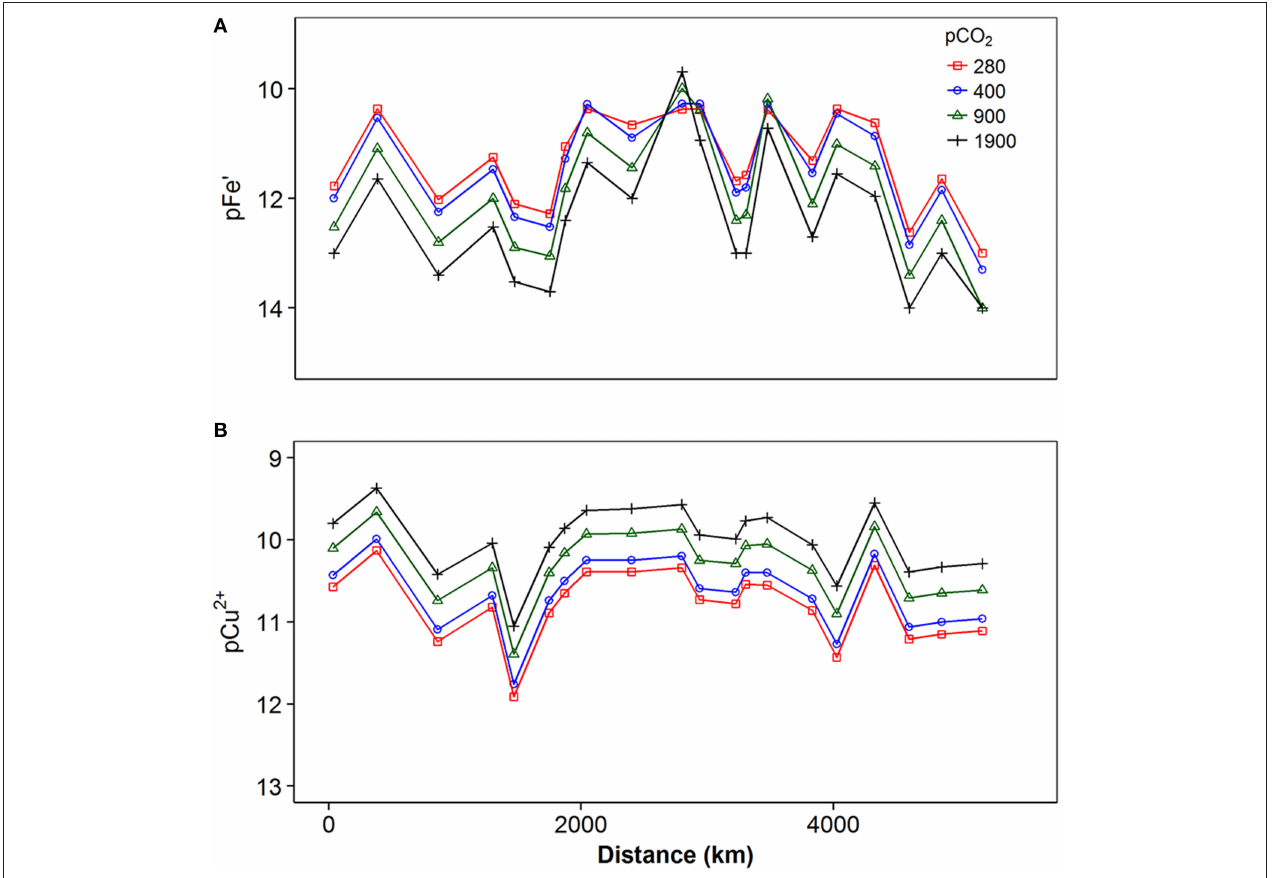
FIGURE 9 | Concentration of (A) inorganic iron expressed as pFe’ (-log[Fe’]) and (B) free copper expressed as pCu 2 + (-log[Cu 2 + ]) calculated for different pCO 2 levels from preindustrial (280 µ atm) to approximately five times current values (1900 µ